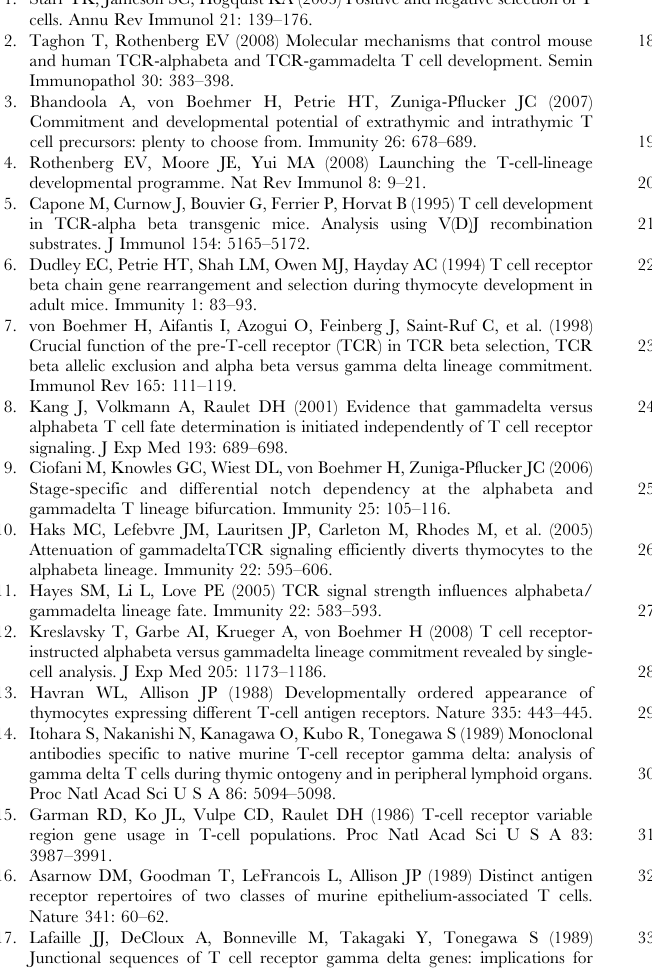
Figure S8 Deletion of Tcrd does not restore thymus cellularity in Id3 2 / 2 mice. (A) Total thymocytes numbers in mice of the indicated genotypes. At least 4 mice were analyzed for each genotype. p , 0.01 for Id3 + / + Sh2d1a 2 / 2 or Id3 2 / 2 Tcrd 2 / 2 com- pared to Id3 + / + Tcrd 2 / 2 . Found at: doi:10.1371/journal.pone.0009303.s008 (3.93 MB